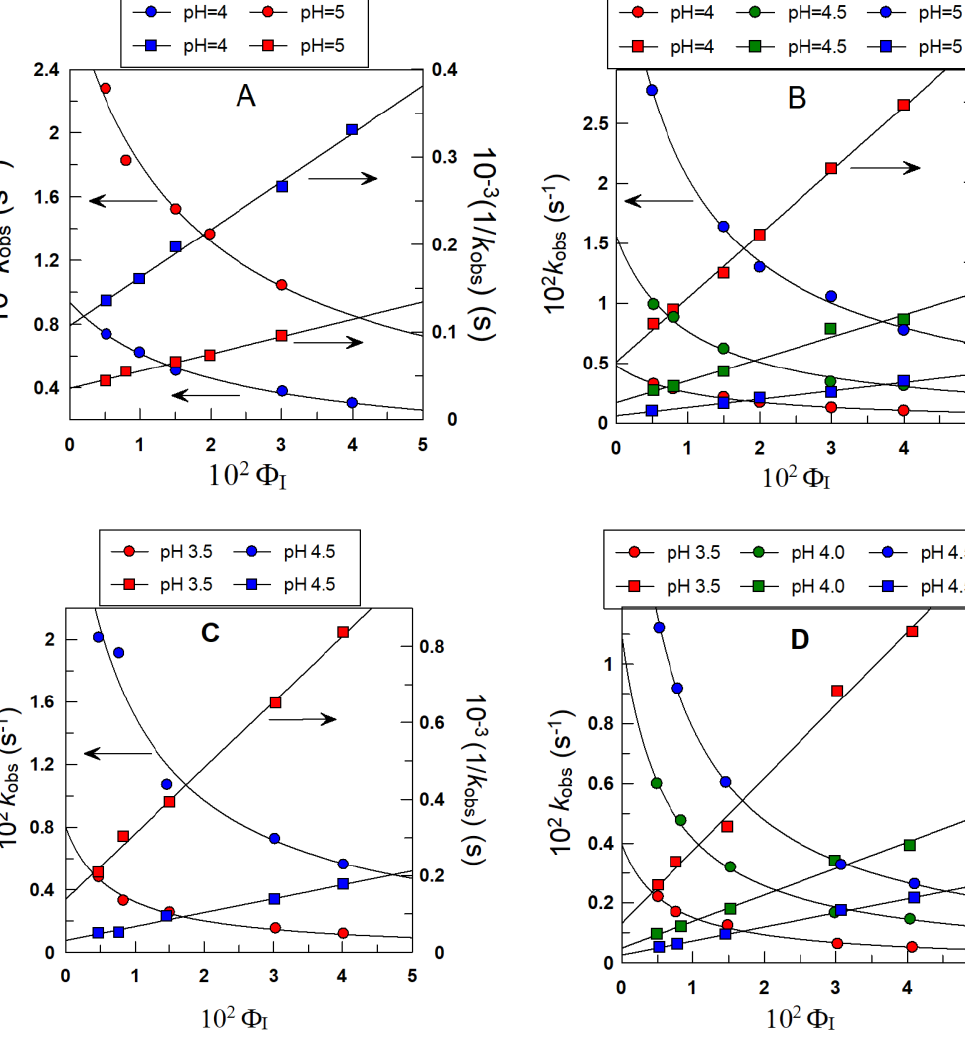
Figure 3. Variations in k obs with Φ I for the reaction between 16-ArN 2+ and the antioxidants α - ( A , C ) and δ -TOC ( B , D ) in 1:9 olive ( A , B ) and soybean ( C , D ) o/w emulsions prepared with buffered aqueous solutions of different acidity. Experimental conditions δ -TOC ([ δ -TOC T ] = 4.0 × 10 − 3 M) y (B) α -TOC ([ α -TOC T ] = 4.0 × 10 − 3 M), T = 25 ◦ C. Table 1. Values for P OI of α - and δ - tocopherol (TOC) and for the rate constant in the interfacial region ( k I ) for the reaction between 16ArN 2+ and TOC in emulsions prepared with olive and soybean oils at different acidities.